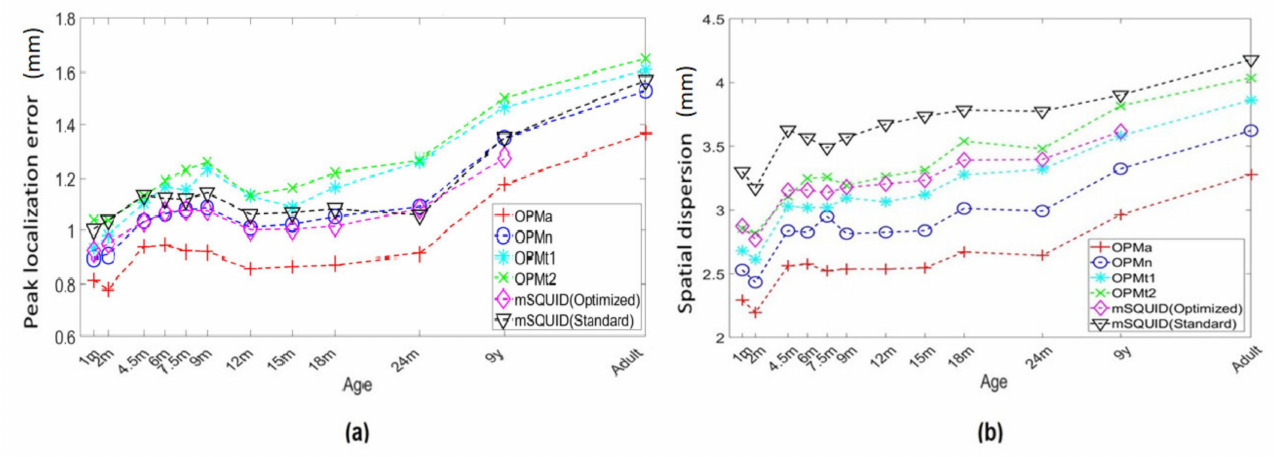
Figure 8. Comparison of array configurations for L2-MNE estimation. ( a ) PLE and ( b )